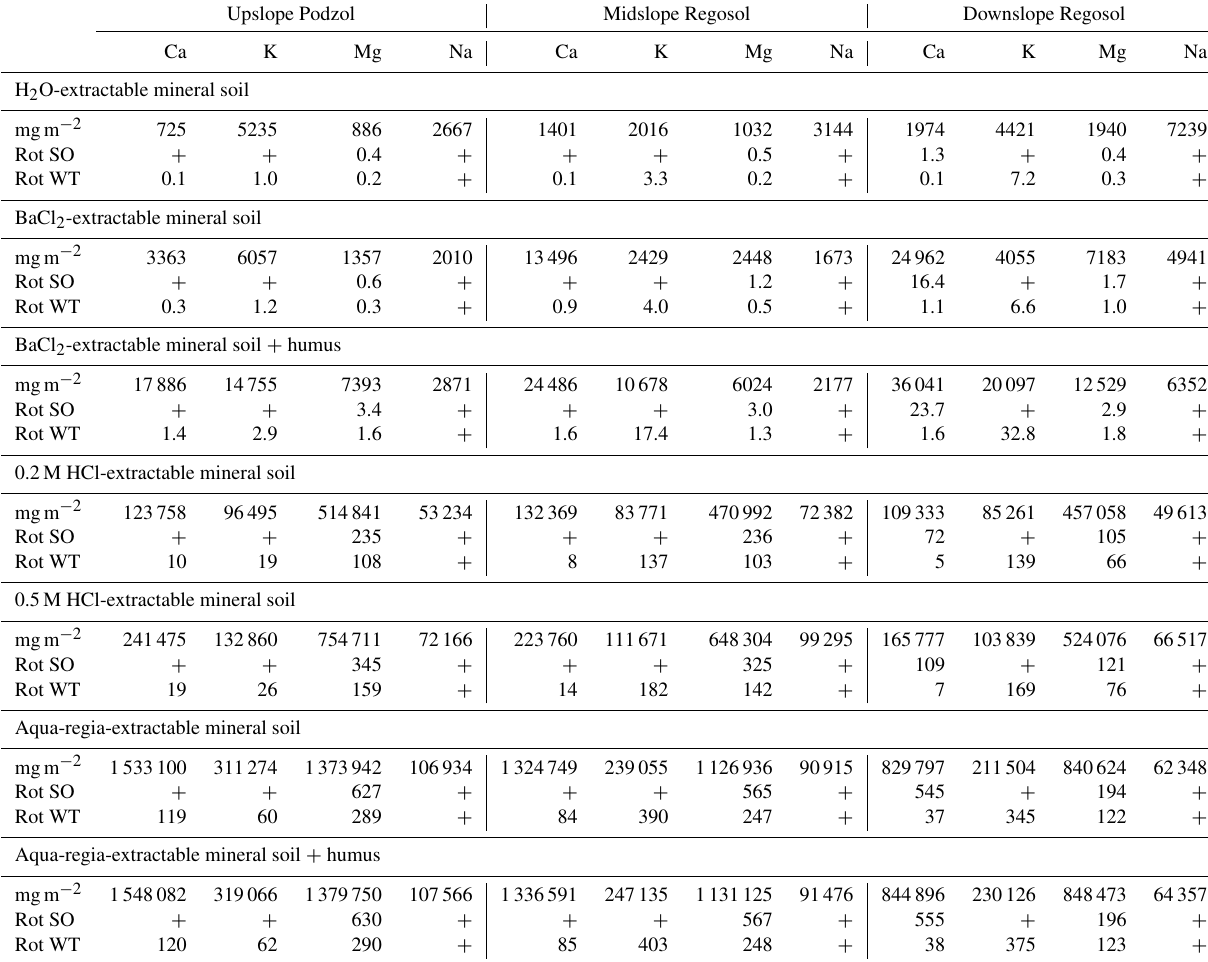
Table 3. Number of forest harvest rotations (65 years) each base cation pool may offset net ecosystem losses for each of the three soils. All extractions were performed on the mineral soil. For BaCl 2 and aqua regia extractions, humus samples from nearby soils were separately sampled and analyzed, and these humus-derived pools have been added to the mineral soil pools for